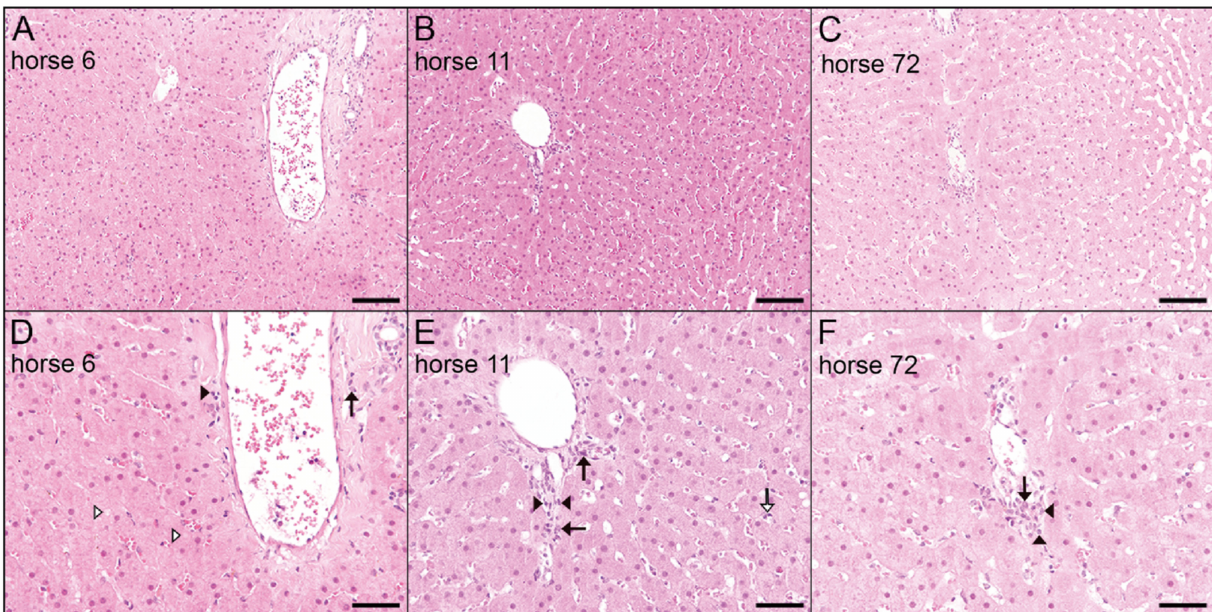
Figure 2. Histological results from biopsies of chronically EqPV-H-infected horses. ( A , D ) HE staining of liver biopsy samples of horse 6 with mild multifocal hepatocellular lipidosis (white arrowheads) and mild periportal infiltration with lymphocytes (black arrowhead) and macrophages (black arrow). ( B , E ) Mild periportal infiltration with lymphocytes (black arrowheads) and macrophages (black arrows) and a minimal, randomly distributed, suppurative inflammation (white arrow) within the liver of horse 11, HE. ( C , F ) Mild periportal infiltration with lymphocytes (black arrowheads) and macrophages (black arrow) within the liver of horse 72, HE. Images were taken at 10x magnification, 100 µ m scale bar ( A – C ) and 20 × magnification, 50 µ m scale bar ( D – F